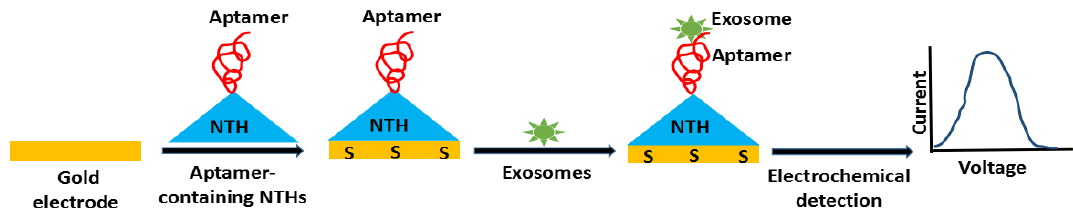
Figure 3. Schematic illustration of DNA nanotetrahedron (NTH)-assisted aptasensor . Ho et al. proposed a disposable EB for detecting alpha-enolase 1 (ENO1), a specific lung cancer biomarker, with a LOD of 11.9 fg/mL [56]. Huang and his team discovered an